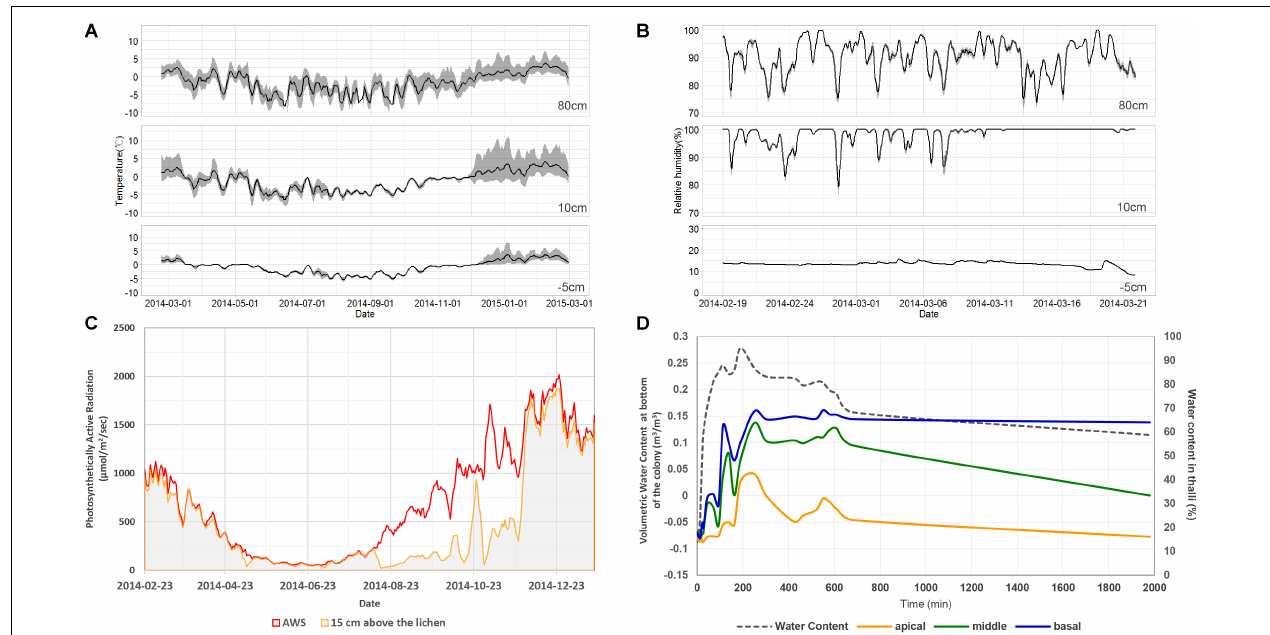
FIGURE 2 | Microenvironments of the habitat of Cladonia squamosa . (A) Air temperature at 80 and 10 cm aboveground and substrate temperature at 5 cm underground from February 19, 2014 to February 28, 2015. Simple moving average and data range over the past 5 days were represented by the solid line and gray shade, respectively. (B) Relative humidity at 80 and 10 cm aboveground and volumetric water content of substrate at 5 cm underground from February 19 to March 21, 2014. Simple moving average and data range over the past 5 days were represented by the solid line and gray shade, respectively. (C) Day average of PAR at 80 and 15 cm aboveground from February 19, 2014 to January 20, 2015. (D) Water contents at apical, middle, and basal parts of the thalli according to continuous water supply to the substrate and air-dry of the colony in the